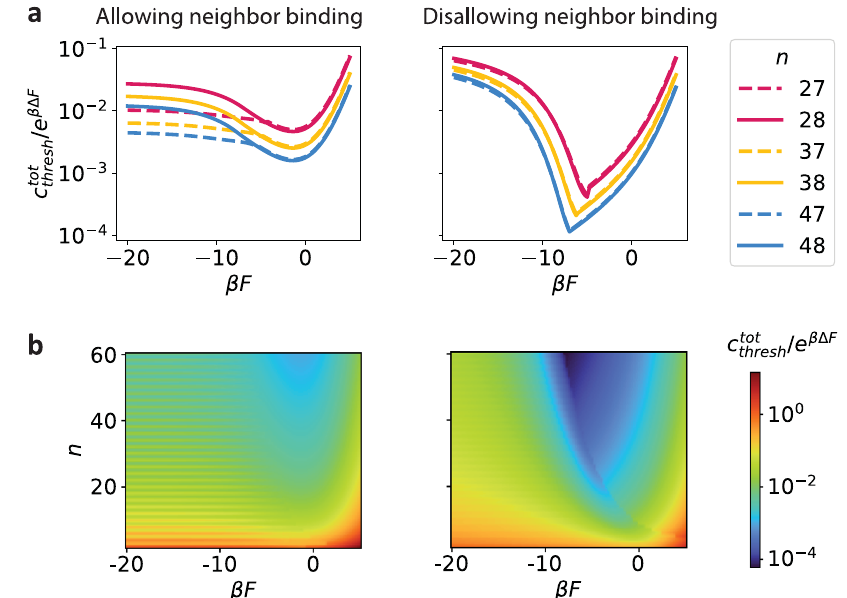
Fig.5|Phasediagram.a Reentranttransitionintheanalyticalmodel :Theanalytical model enables enumeration up to arbitrarily large m , and reveals a reentrant transition. With high enough concentrations of RNA, aggregation is always possi- ble; however, for certain concentrations, the analytical model predicts the system will undergo a reentrant phase transition in agreement with computational results (Fig. 4). Panel a shows slices for certain values of n through the complete phase diagram shown in panel ( b ). Parity of n affects aggregation phenomena for the systemallowing neighbor binding (LHS). b Completephase diagram :Thecomplete phase diagram as predicted by enumeration up to arbitrarily large m with the